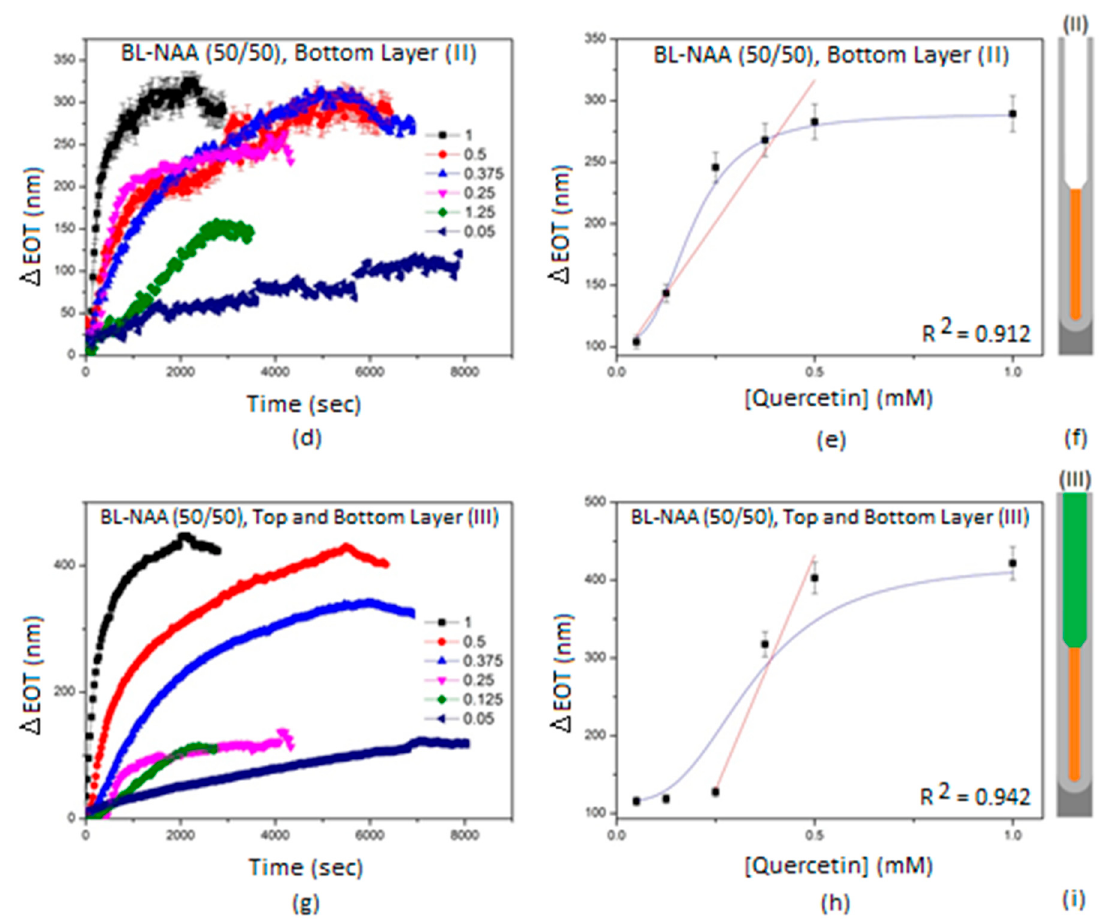
Figure 6. Time response curve showing effective optical thickness changes and sigmoidal curve fitting for BL-NAA (50/50) (funnel structure with equal top layer with large diameters and bottom layer with smaller pore diameters) sensing platforms measured by RIfS as a function of quercetin concentration (0.05, 0.125, 0.25, 0.375, 0.5, and 1 mM). ( a ) Δ EOT (I) generated from the top structural layer of the BL-NAA (50/50) platform; ( b ) Sigmoid fit (blue) and the linear fit (red) for BL-NAA (50/50) between Δ EOT (I) and the different concentration of quercetin (0.05, 0.125, 0.25, 0.375, 0.5, and 1 mM) are presented; ( c ) Scheme of representative optical layer as a function of Δ EOT (I) assessment; ( d ) Δ EOT (II) generated from the bottom structural layer of the BL-NAA (50/50) platform; ( e ) Sigmoid fit (blue) and the linear fit (red) for BL-NAA (50/50) between Δ EOT (II) and the different concentration of quercetin (0.05, 0.125, 0.25, 0.375, 0.5, and 1 mM) are presented; ( f ) Scheme of representative optical layer as a function of Δ EOT (II) assessment; ( g ) Δ EOT (III) generated from the top and bottom